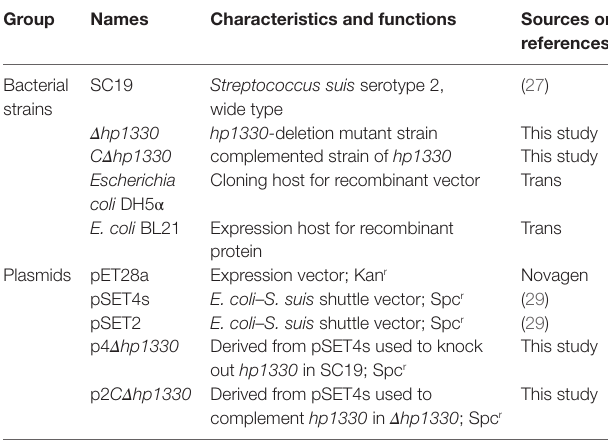
Table 1 | Summary of bacterial strains and plasmid used in this